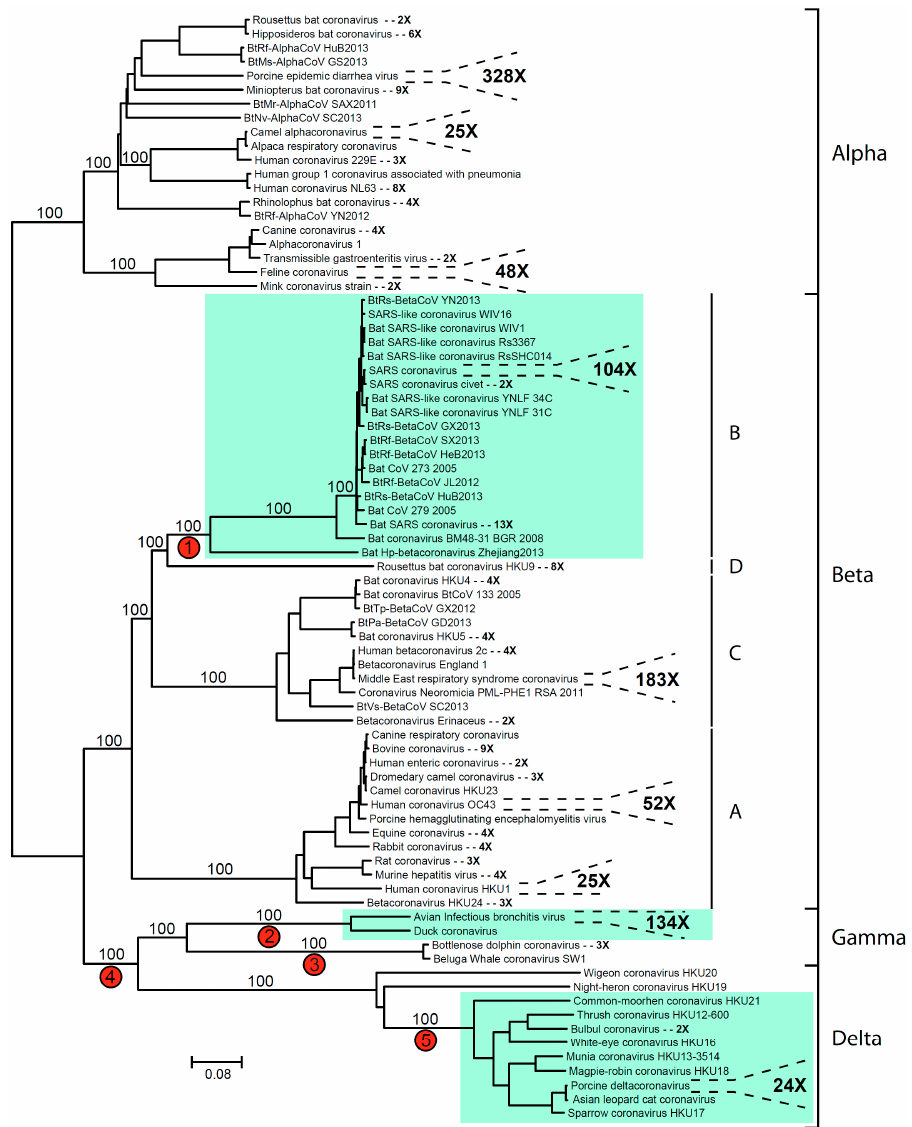
Figure 1. Coronavirus phylogeny with s2m-containing sequences highlighted. ORF1ab polyprotein amino acid sequences were aligned using the program MUSCLE [8] and default parameters. The phylogenetic analysis was performed using the program SeaView [9] and the neighbor joining clustering method with Kimura two-parameter distances. In order to avoid large clades of closely related sequences, operational taxonomic units (OTUs) with similar GenBank taxonomical annotation and almost identical sequences were identified and basal members of these monophyletic groups chosen to represent such sequence clusters. For instance, there are 183 complete ORF1ab polyprotein sequences available from different strains of the Middle East respiratory syndrome (MERS) coronavirus. These sequences are represented by a single accession (in this case, GenBank accession number ALB08298; isolate KOREA/Seoul/035-1-2015). Based on visual inspection of the alignment it was determined that the sequences belonging to the Torovirinae subfamily could not be reliably aligned and were excluded from the analysis. Brackets show serogroups as well as betacoronavirus lineages and key branches with 100% bootstrap support (100 pseudoreplicates) have been indicated. Red circles indicate possible losses/gains of s2m (see discussion in